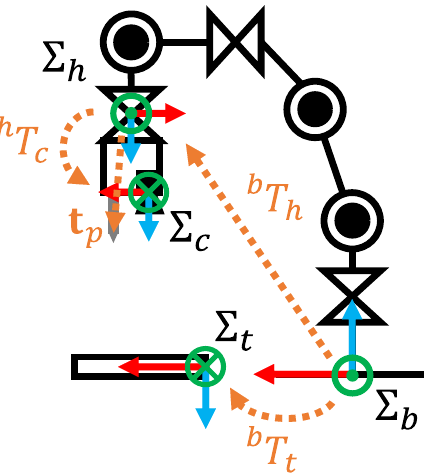
Figure 5. The free body diagram of the